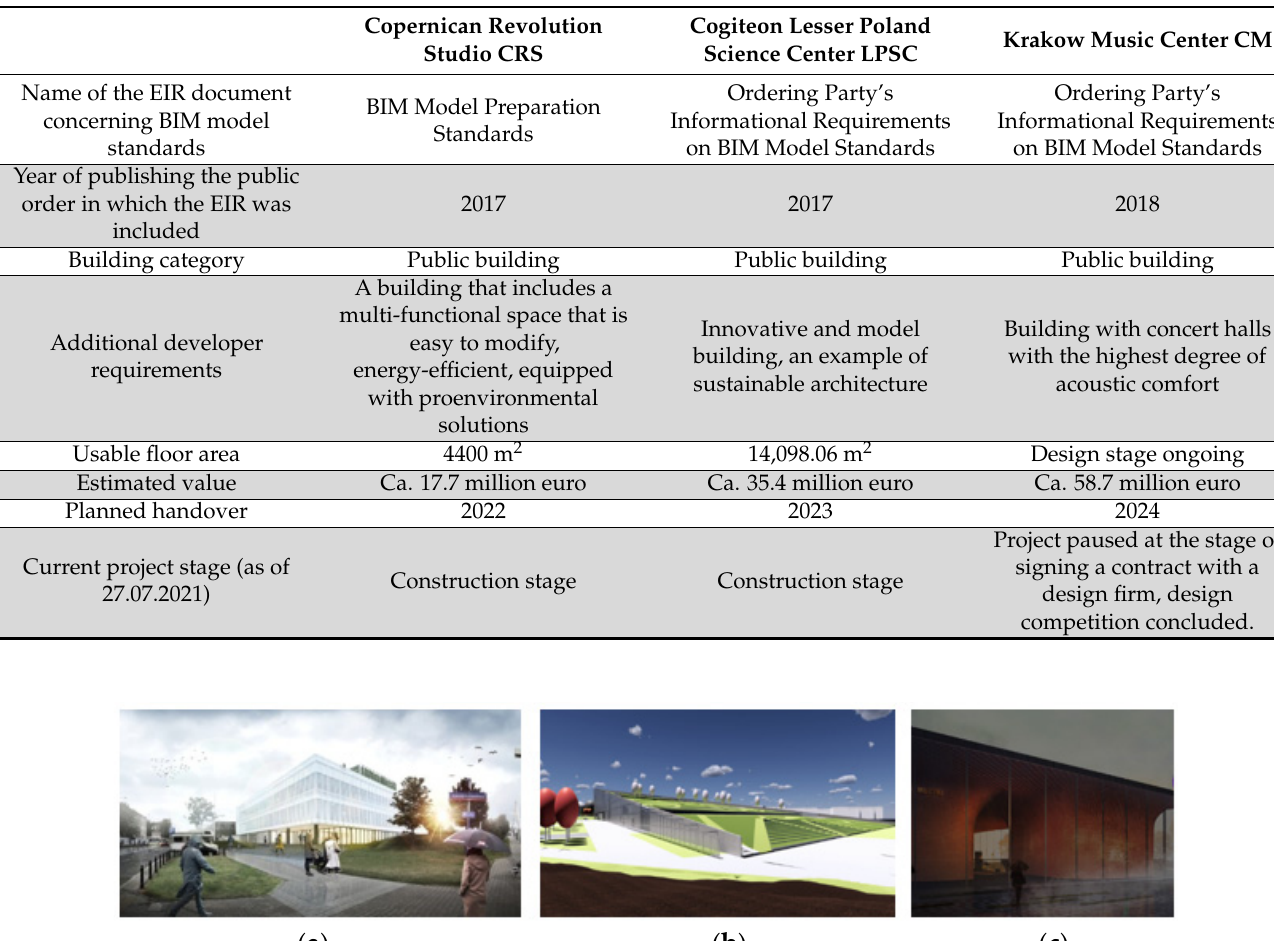
Table 1. Brief overview of projects for which an analysis of Employer’s Information Requirements was performed to the extent of BIM application.